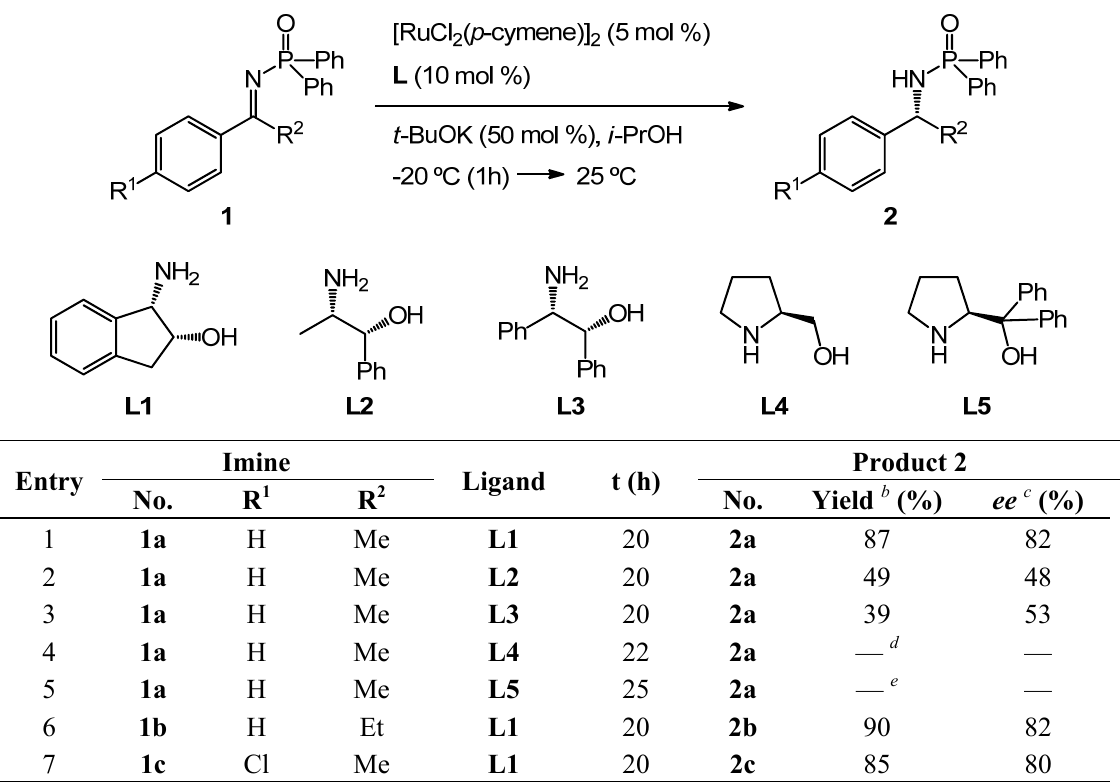
Table 2. Test of different amino alcohols as chiral ligands for the ruthenium-catalyzed transfer hydrogenation of N -phosphinylimines 1 a